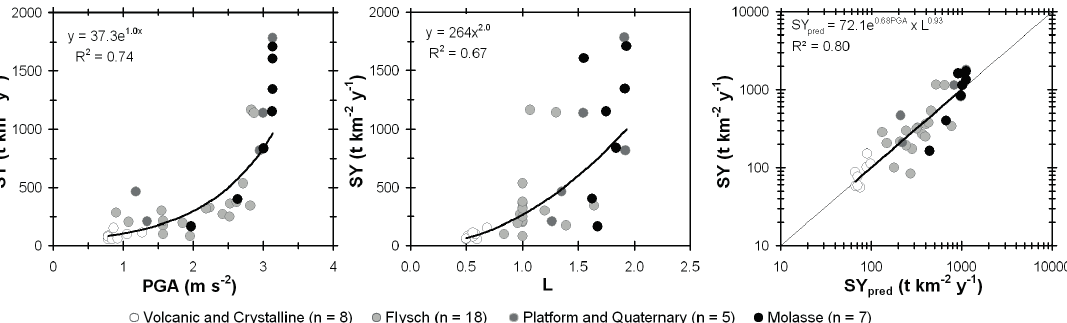
Fig. 2 Average observed sediment yield (SY) versus PGA (the Peak Ground Acceleration with a recurrence interval of 100 years), L (a catchment lithology erodibility factor as defined by Syvitski and Milliman, 2007) and SY pred (an empirical regression model based on L and PGA and calibrated on the 38 selected subcatchments of the Siret; Fig.